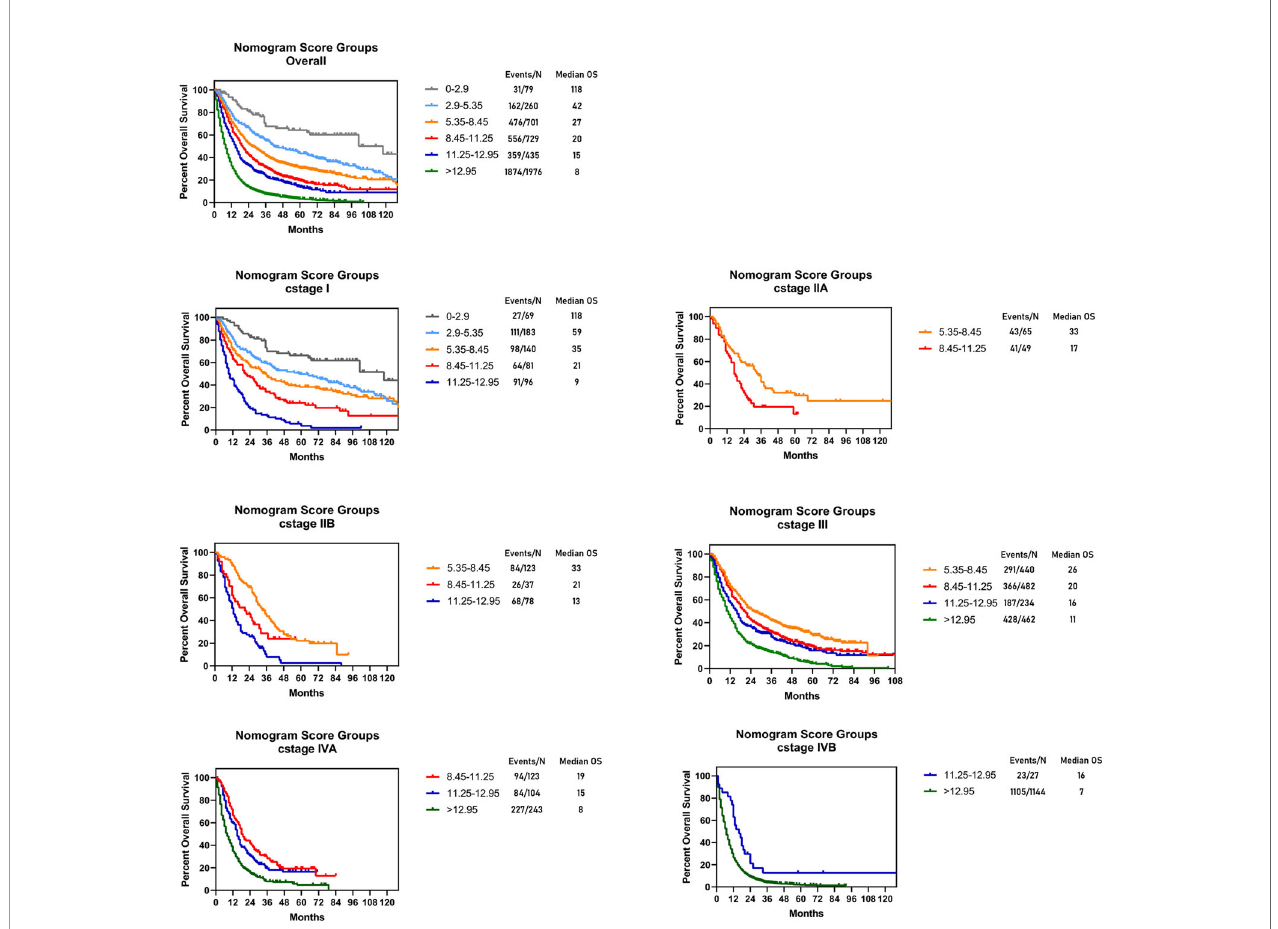
FIGURE 4 | Risk group strati fi cation within each TNM stage in the training cohort. Subgroups with fewer than 10 patients were omitted from the